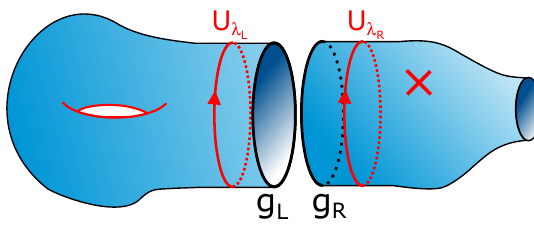
Figure 6 . Gluing two BF sectors along one boundary in terms of two particle-on-a-group models g L and g R